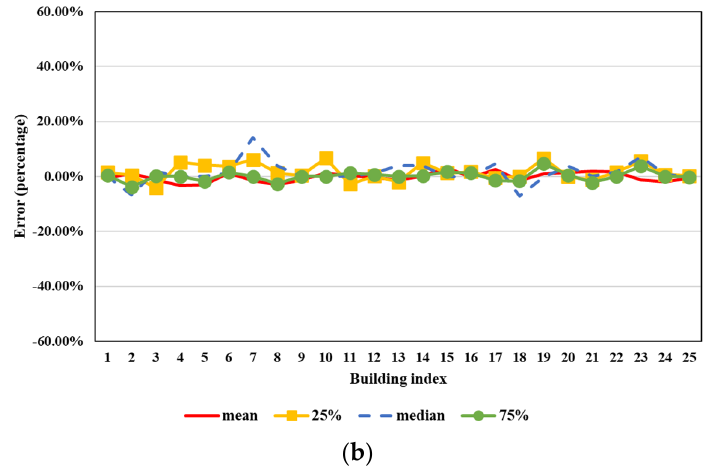
Figure 12. Relative differences of different wind angle steps and RCP scenarios. ( a ) Relative difference of wind power potentials between wind angle steps of 5° (baseline) and 10° (RCP4.5). ( b ) Relative difference of wind power potentials between RCP4.5 (baseline) and RCP8.5 ( ∆α = 5°).